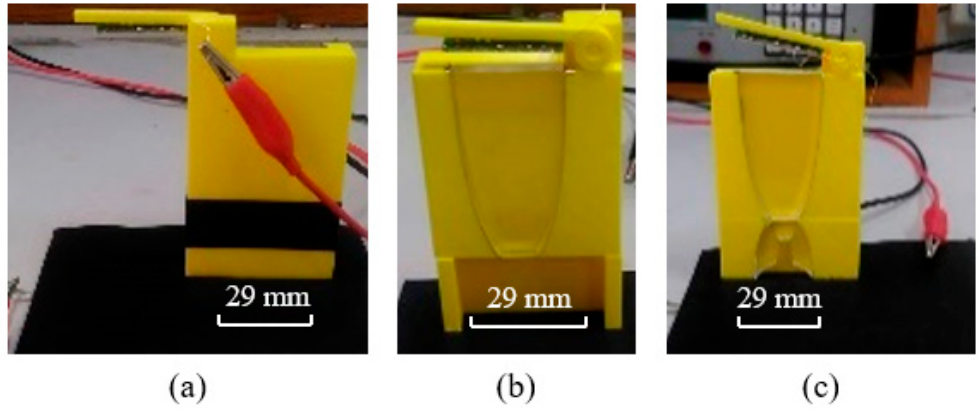
Figure 30. The experimental results of the two-dimensional (2D) prototype: ( a ) the naked PV panel; ( b ) the NACPC; ( c ) the NACPC with the new elliptical collimator.